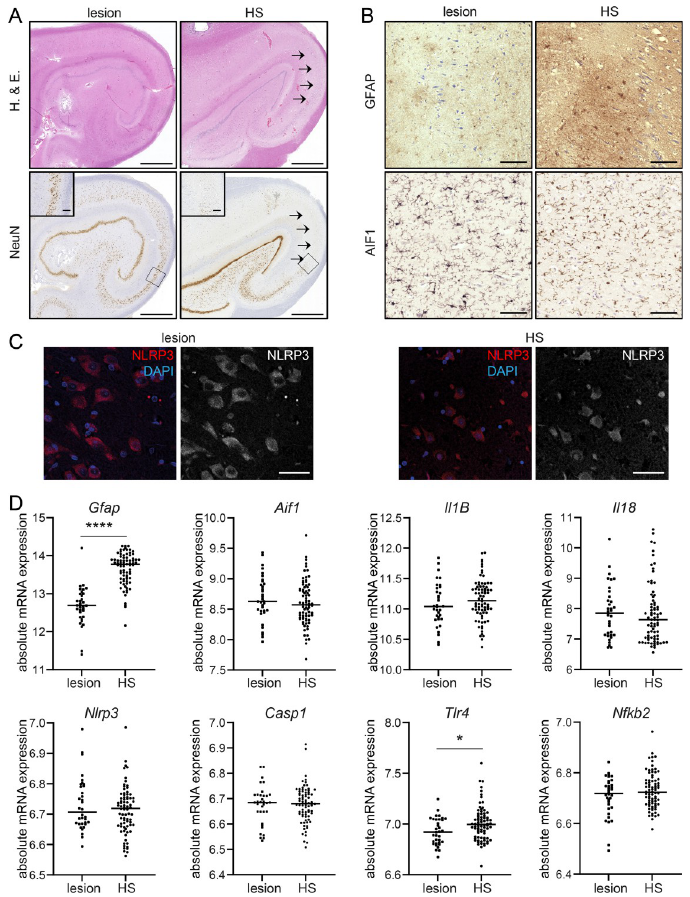
Fig 6. Activation of NLRP3-signalling associated genes in human TLE hippocampi. ( A ) Representative NeuN immunohistochemistry reveals a classical pattern for HS-TLE with segmental neuronal loss pronounced in CA1 (rightmost, arrows) whereas neurons are well conserved in the lesion-associated hippocampus. Scale bars: 500 μ m (overview), 100 μ m (insert). ( B ) Only scattered astrocytes are observed in lesion-associated TLE (leftmost, see inserts), compared with pronounced fibrillary reactive astrogliosis in HS-TLE (leftmost). Similar reactivity of activated microglia (AIF1) is observed in both pathologies (lower panels). Scale bars: 100 μ m. ( C ) Representative NLRP3 immunolabeling also shows a similar expression pattern in both TLE forms. Scale bars: 50 μ m. ( D ) mRNA level of Gfap , Aif1 , Il1B , Il18 , Nlrp3 , Casp1 , Tlr4 and Nfkb2 are determined with RNA sequencing in HS-TLE (n = 78) and lesion-associated TLE patients (n = 34). Data is analysed with Mann-Whitney U test. Asterisks indicate significant differences between groups: � p < 0.05, ���� p <